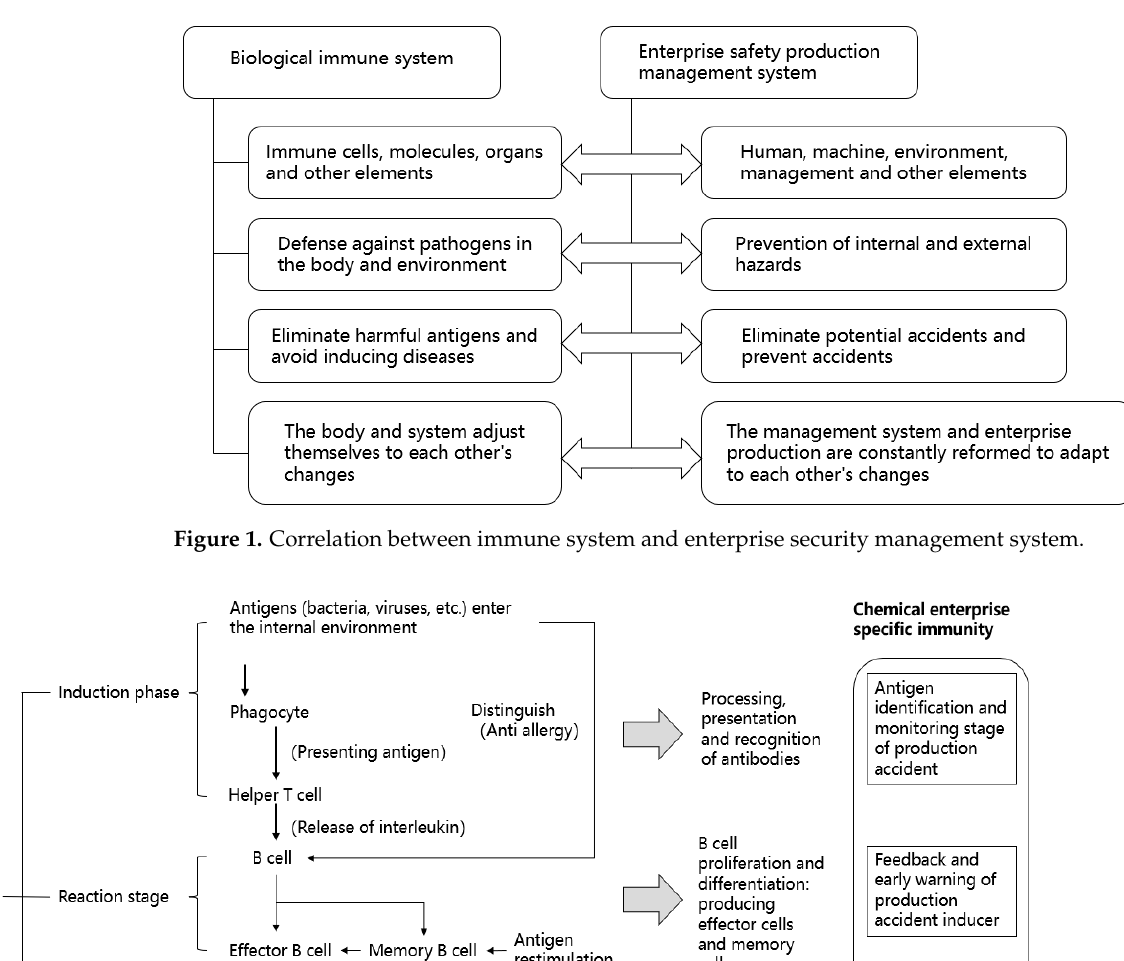
Figure 1. Correlation between immune system and enterprise security management system.